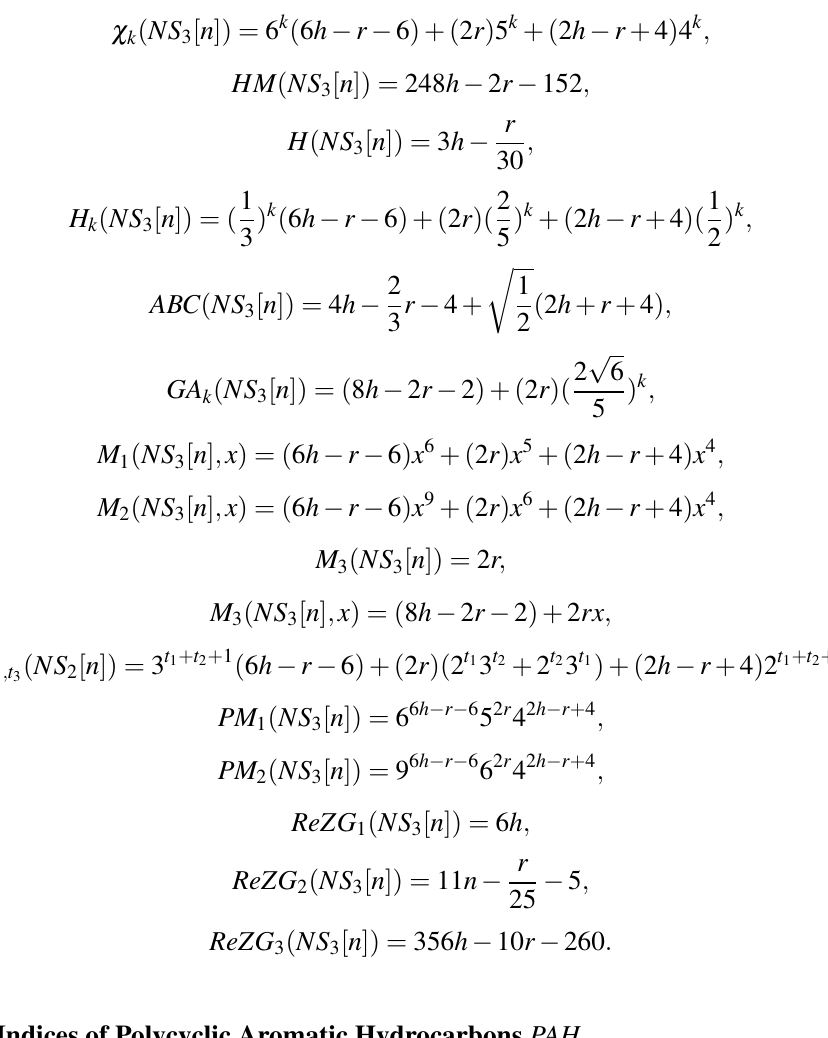
Fig. 11 A phenylene (PH) and its hexagonal squeeze